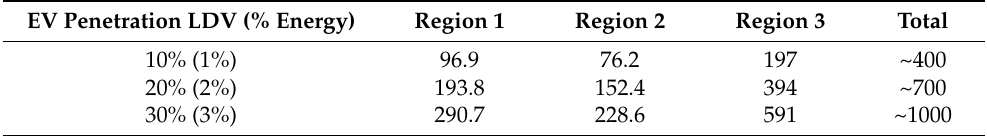
Table 3. The number of vehicles in each region, in thousands, is shown in columns 2 to 4 of the table, and the total number of vehicles is shown in the column on the right. Table 3. EV penetration in thousands of vehicles as a percentage of LDVs and of the annual system load, and the number of vehicles assumed in each region.